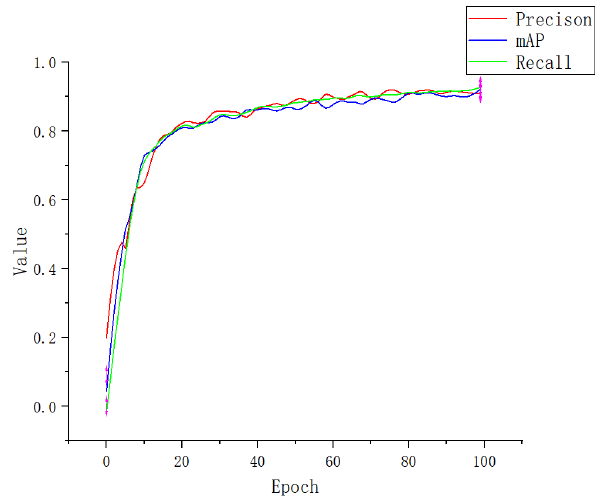
Figure 13. Performance index curve of ECA.